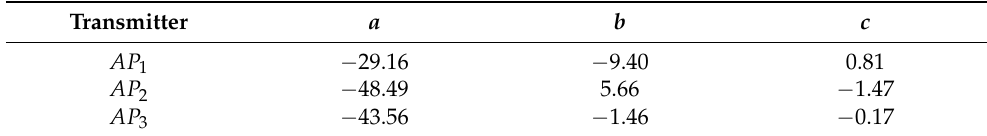
Table 5. Parameter estimation of polynomial fitting